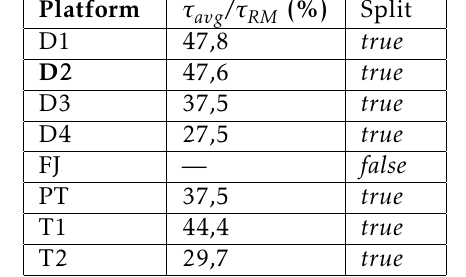
Table 5. Metrics measured at the time of self-organizing